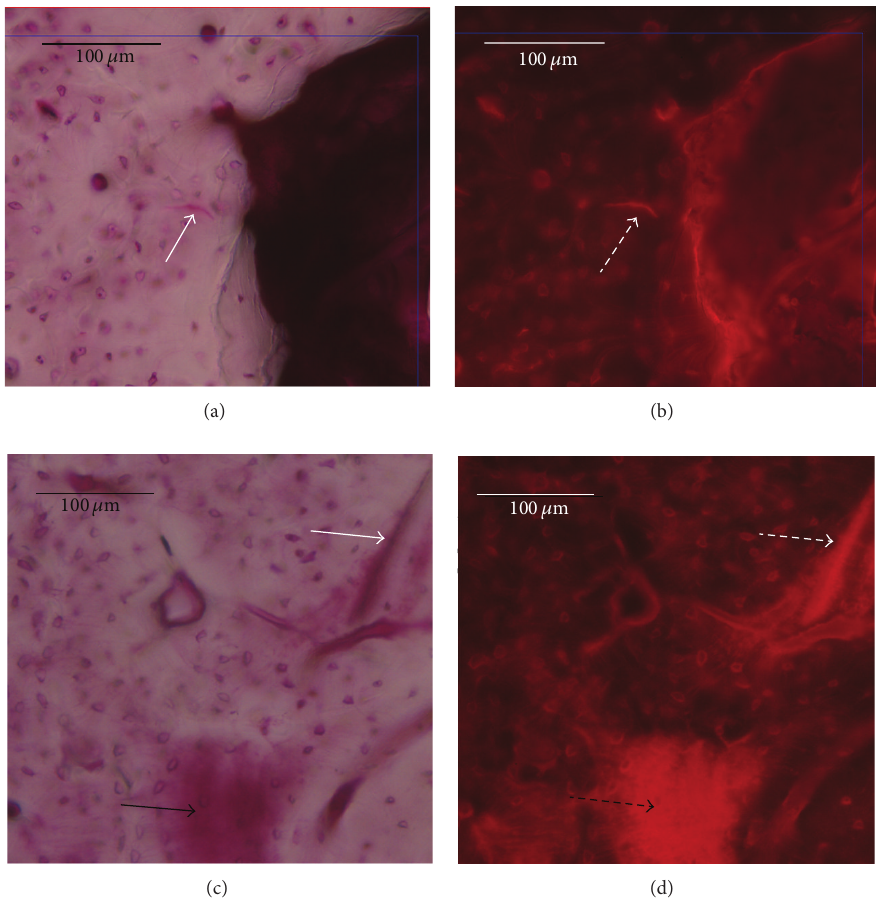
Figure 2: Basic fuchsin staining showing microcracks (white arrow) in (a) OVX 2nd week group rats and (c) OVX 1st week group rats. (b, d) Red epifluorescent light microscopy showing the same microcrack (white dashed arrow) in the identical view. Diffused microdamage (black arrow) was detected in (c) cortical bone (black arrow) and under (d) red epifluorescent light microscopy (black dashed arrow). Scale bars = 100 𝜇